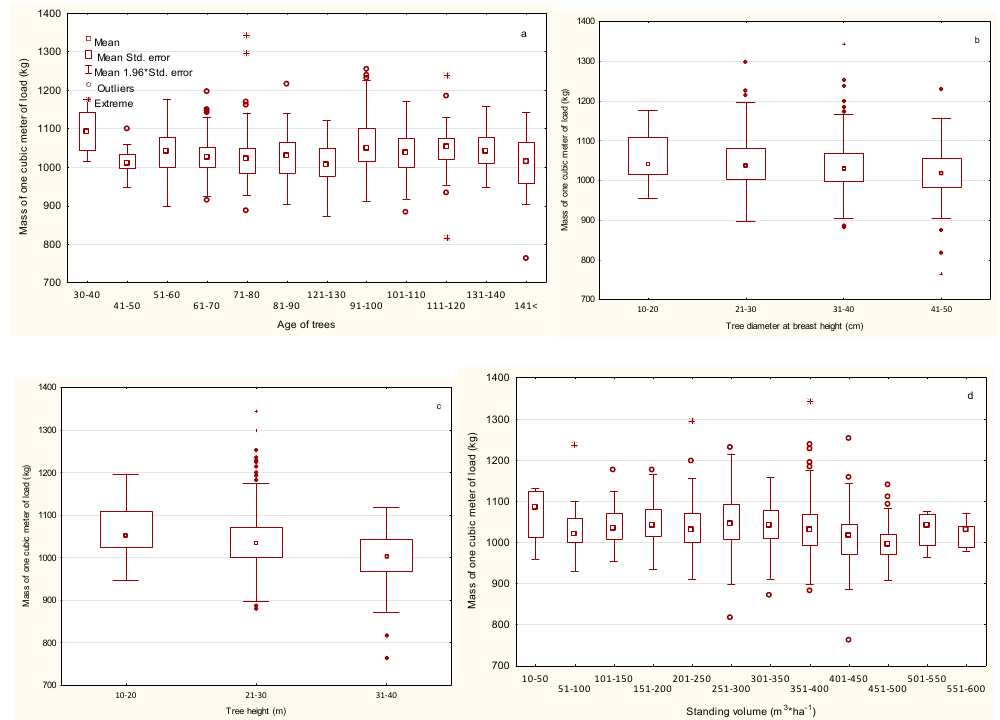
Figure 6. Comparison of average mass values of 1 m 3 of load depending on the stand characteristics from which the timber was harvested. ( a ) stand age, ( b ) diameter at breast height (DBH), ( c ) stand height, ( d ) abundance.